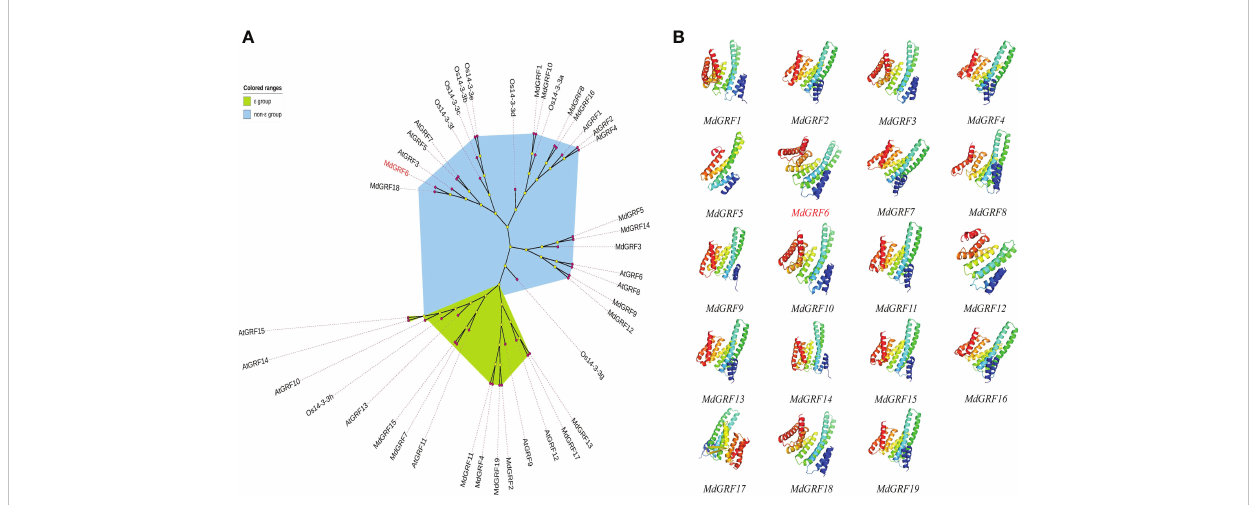
FIGURE 1 Phylogenetic tree and protein structures of Md14-3-3s. (A) The NJ phylogenetic tree (1,000 bootstrap replicates) was generated with 14-3-3 proteins from apples, rice, and Arabidopsis . (B) Phyre2 in ‘ Normal ’ mode and Pymol were used to generate all 3D models of MdGRFs. Images were colored by rainbow N ! C terminus. All models were based on template d1o9da or